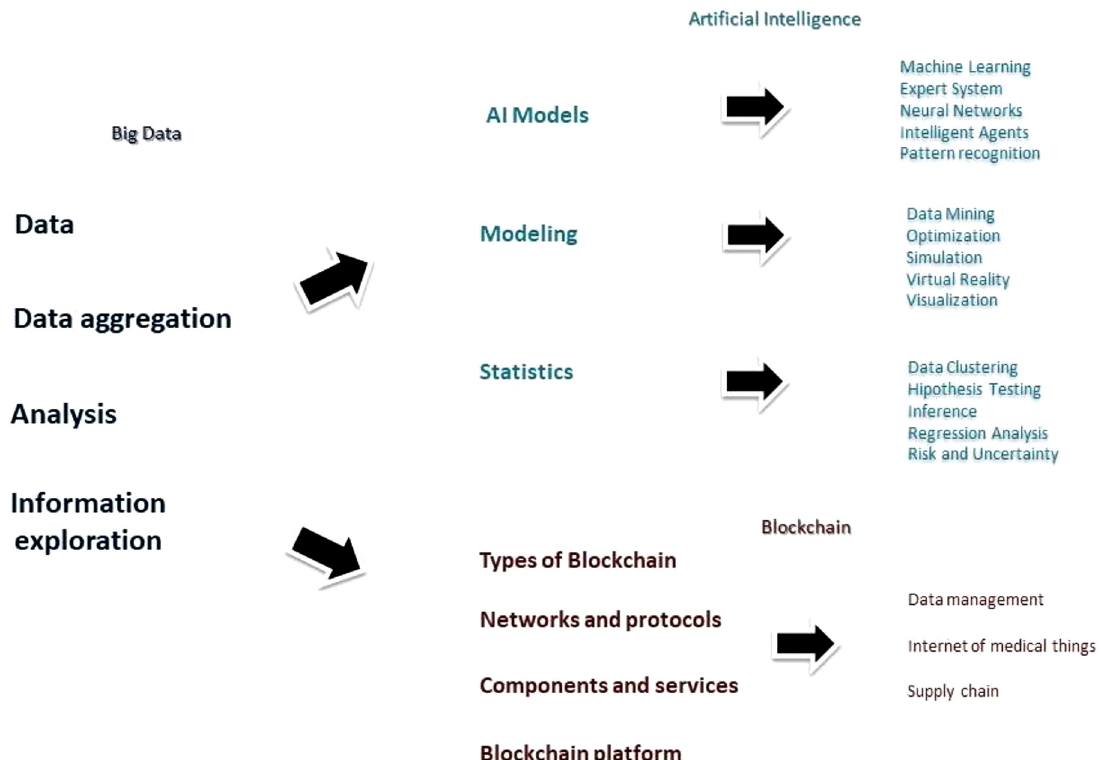
Figure 3: Big data, artificial intelligence and blockchain in healthcare. The three technologies have a great synergy. Big data acts as the main source of information of both AI and blockchain, not only for the data recollection but also for the analytic and management processes. The early process of the information with big data allows both technologies to acquire refined data. IA and blockchain amplify and spread the second use of the information, elaborating more convoluted analysis of the information and producing advanced